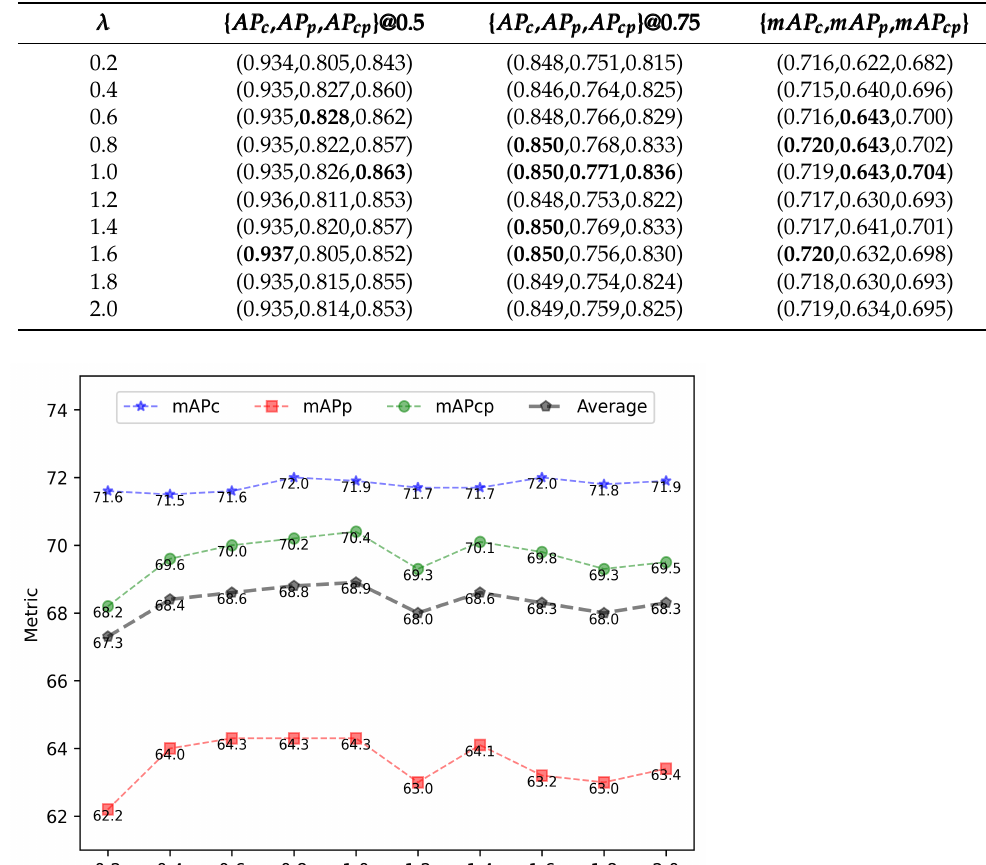
Table 7. Illustration of how the AP metrics of IPH-TOOD change with regard to the weighting coefficient for the loss of predicting human posture on the IPHPDT dataset.